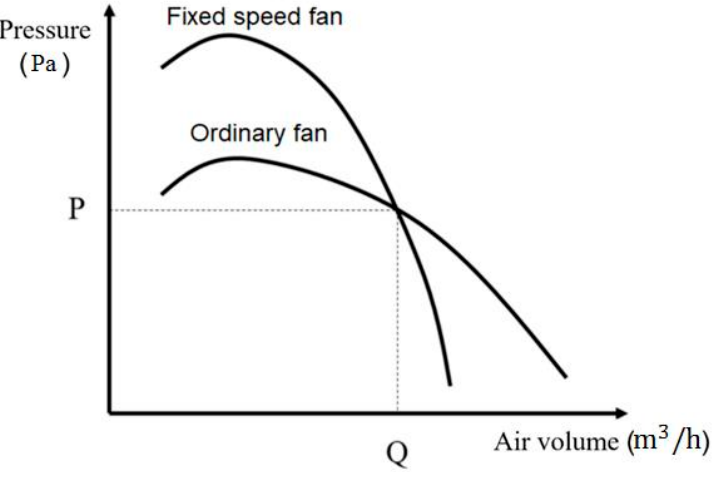
Figure 15. Characteristic curves of the